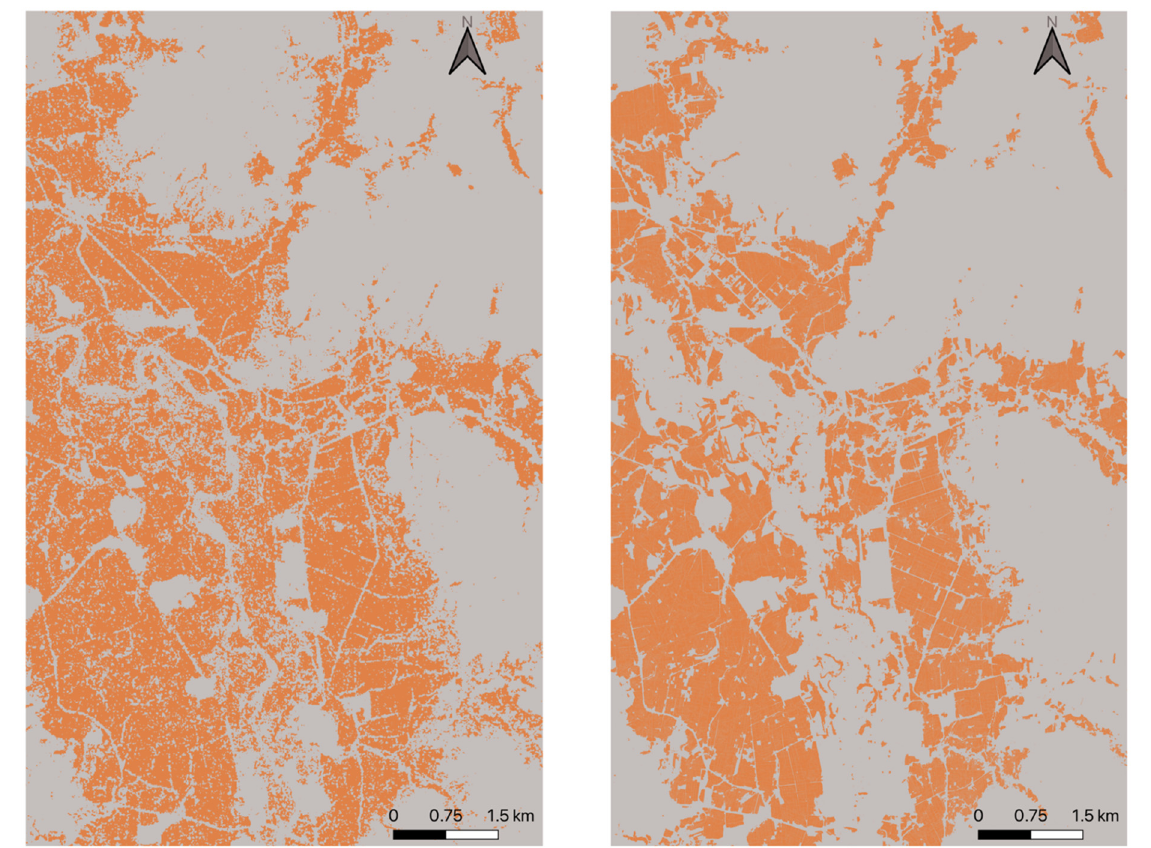
Figure 9. Rice field (orange area) maps produced by the simple decision-tree classifier with Sentinel- 1 SAR imagery ( left ) and by that combined with agriculture field boundary delineation by the SeresNet34-based U-net image segmentation model ( right ). Table 3. Evaluations of rice field mapping results.